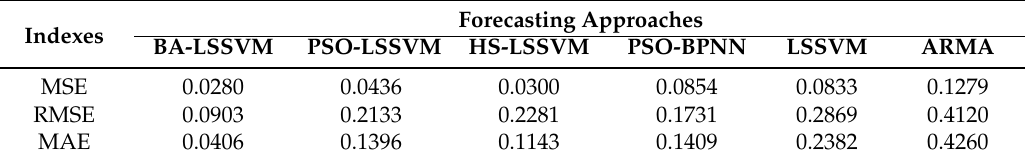
Table 8. The comparison of prediction results with different models.